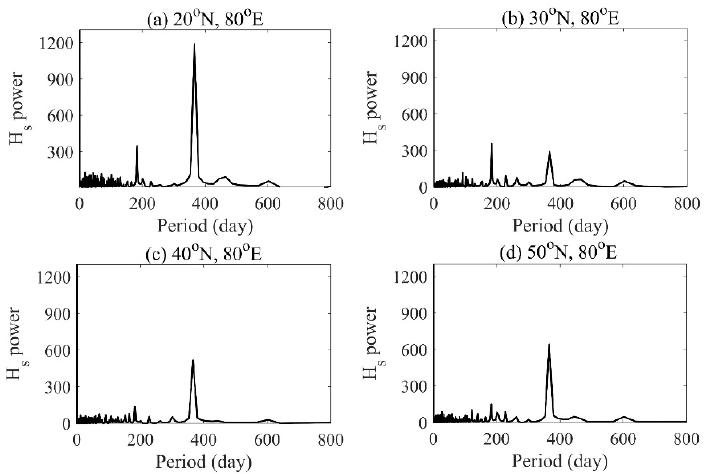
Figure 3. Time series results of periodicity detection acquired using the fast-Fourier transform algo- rithm.